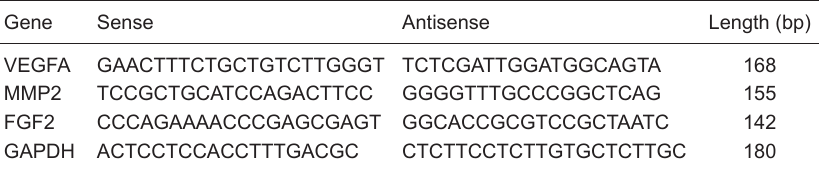
Table 1. Real-time PCR primer